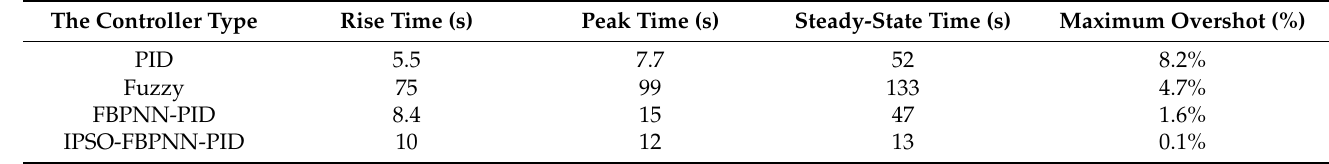
Table 3. Table of performance parameters for pH from 7.1 to 6.3.